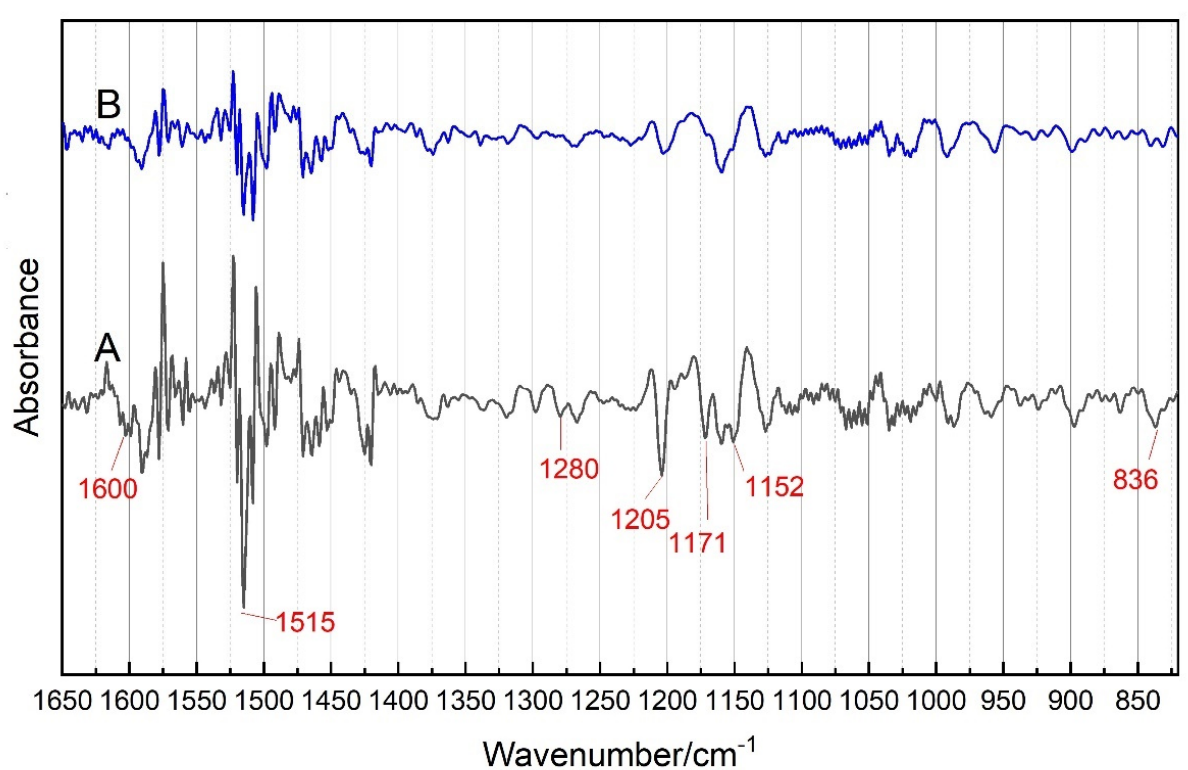
Figure 2. Second derivative IR spectra (SDIR) spectra of pterocarpus bracelet (PB) ( A ) and P. santalinus ( B ).